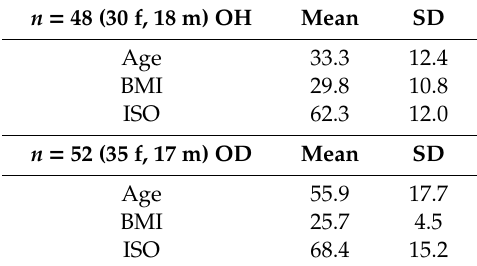
Table 5. Subject characteristics and questionnaire scores.